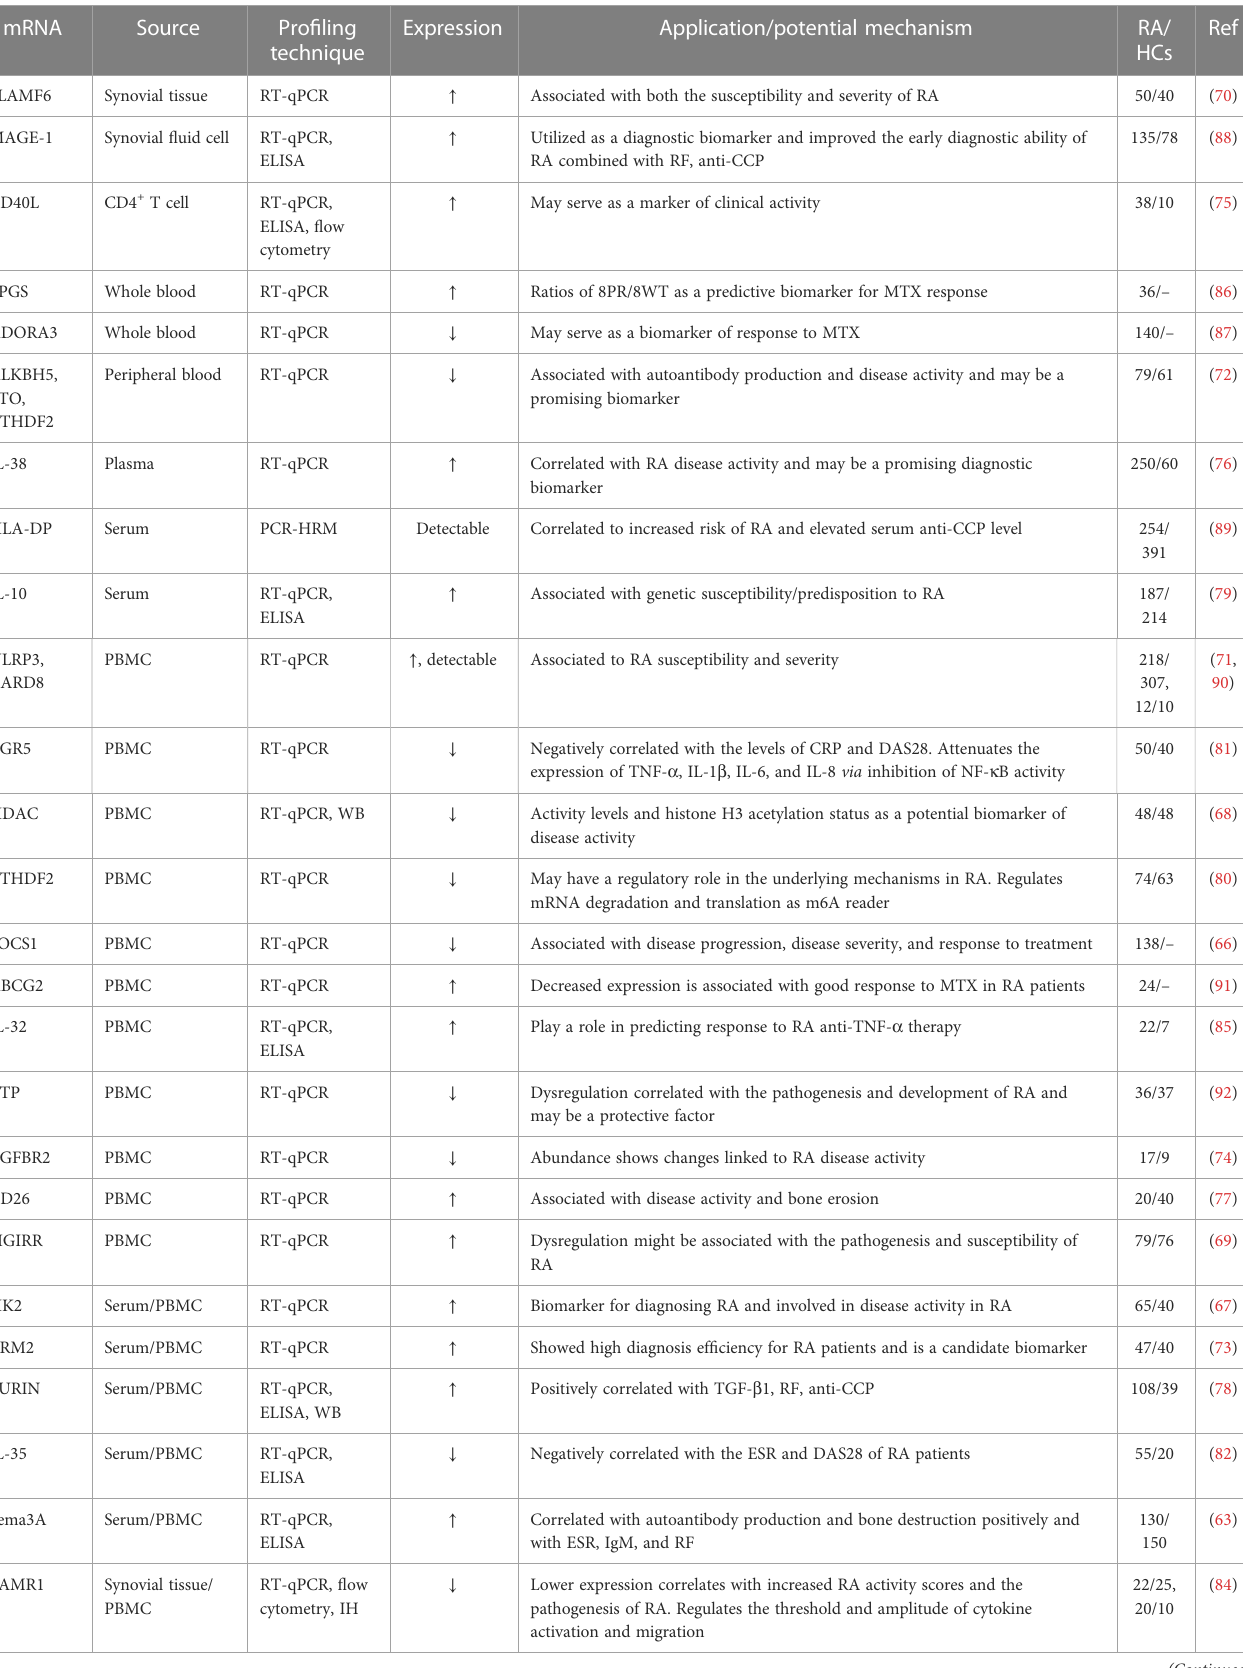
TABLE 1 Potential mRNA biomarkers for